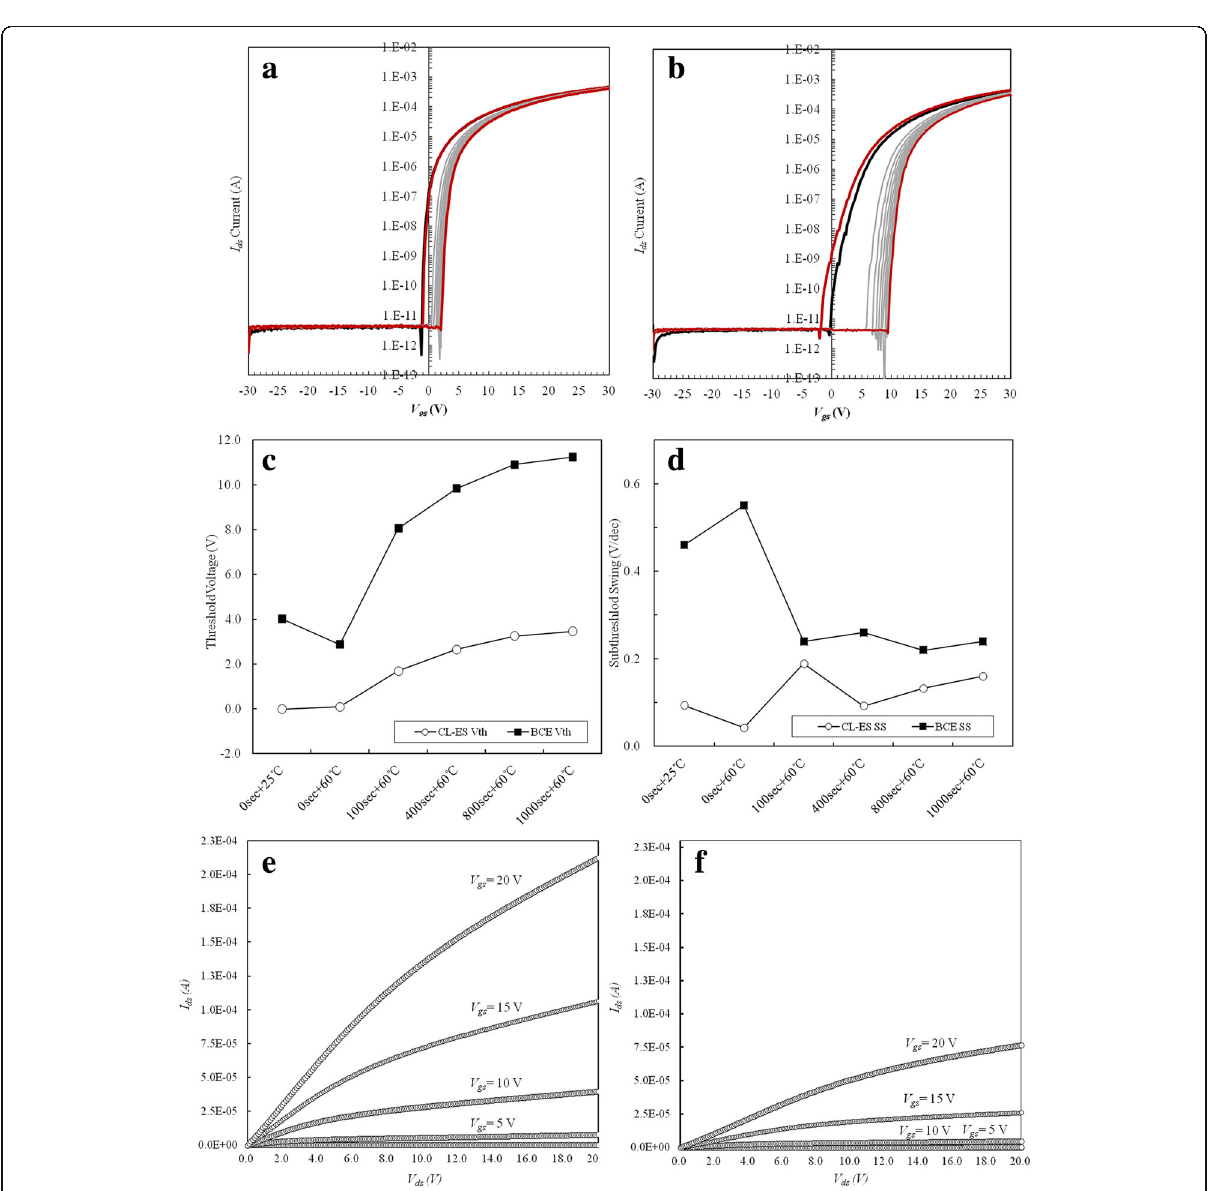
Fig. 7 I - V transfer characteristics measured during the HCS evaluation of a the CL-ES and b the BCE-structured GOA TFTs. Behavior of c the threshold voltage and d the sub-threshold swing at intervals of 1000 s and V ds = 15 V. The initial measurements of the I d -V d output characteristics for e the CL-ES- and f the BCE-structured GOA TFTs with V gs = 0, 5, 10, 15, and 20